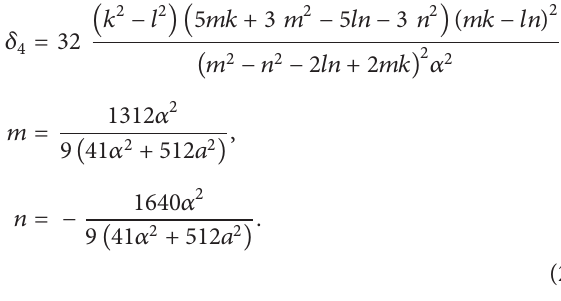
Figure 4(a): The dynamical evolution of bright breather |𝑈(𝑥, 𝑡)| in solution (19) is plotted with parameters 𝑎 = 𝛼 = = 1 , and 𝑙 = 1.6 . 𝑘 = 2 , 𝑏 4 Figure 4(b): The dynamical evolution of bright rogue wave |𝑈(𝑥, 𝑡)| in solution (20) is plotted with parameters 𝑎 = = 1 , and 𝑙 = 1.6 . 𝛼 = 𝑘 = 2 , 𝑏 4 Figure 5(a): The dynamical evolution of dark breather 𝑉(𝑥, 𝑡) in solution (19) is plotted with parameters 𝑎 = 𝛼 = = 1 , and 𝑙 = 1.6 . 𝑘 = 2 , 𝑏 4 Figure 5(b): The dynamical evolution of dark rogue wave 𝑉(𝑥, 𝑡) in solution (20) is plotted with parameters 𝑎 = 𝛼 = = 1 , and 𝑙 = 1.6 𝑘 = 2 , 𝑏 4